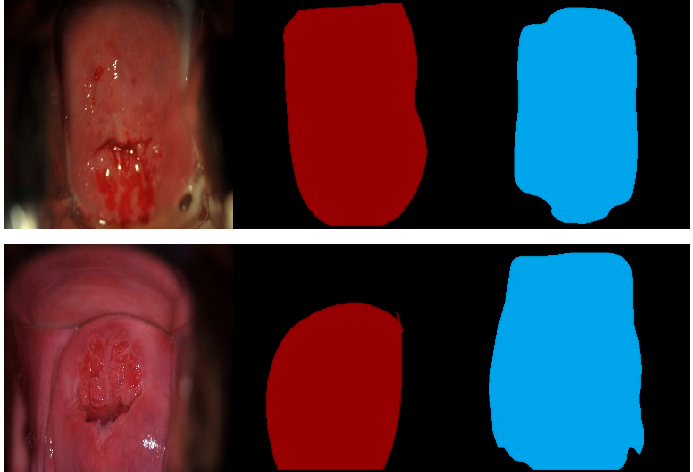
Figure 6. U-Net segmentation examples. Left: original image; middle (red): ground truth; right (blue): automatic segmentation. The top-row segmentation has an intersection-over-union (IoU) score of 0.834, the bottom-row segmentation has an IoU score of 0.671.